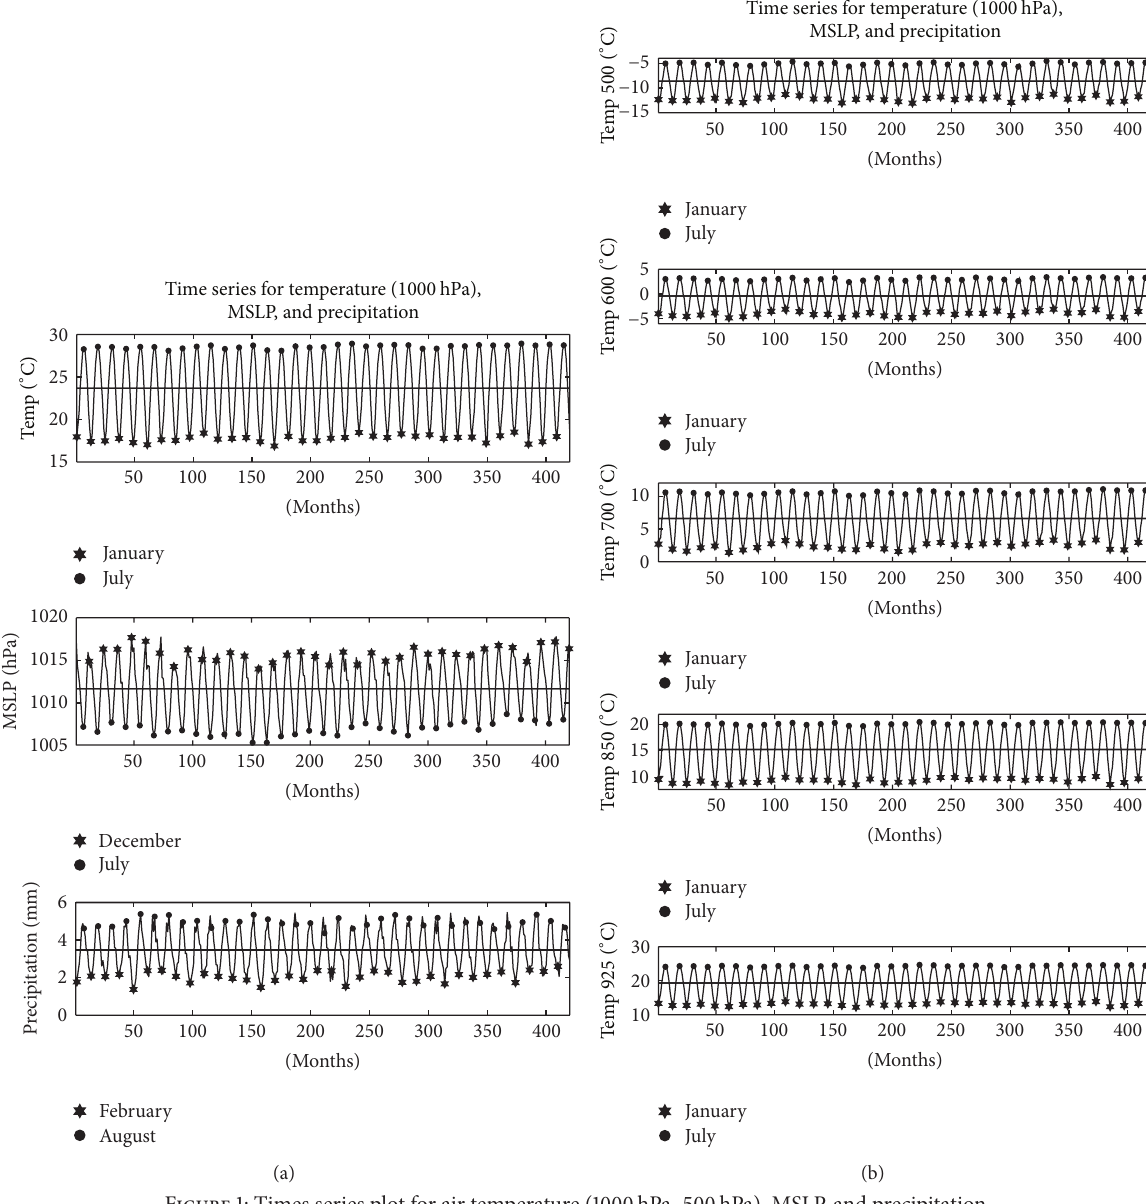
Figure 1: Times series plot for air temperature (1000hPa–500 hPa), MSLP, and